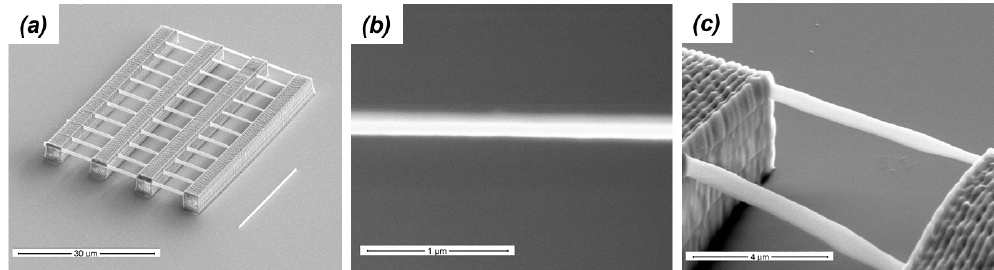
Figure 4. Scanning electron microscopy (SEM) images two-photon polymerization (TPP) suspended lines made with a single laser pass. While the complete structure is shown in ( a ), the top and side views of one of the lines are shown in ( b , c ), respectively. The scale bars are 30, 1, and 4 µm for ( a – c ), respectively.